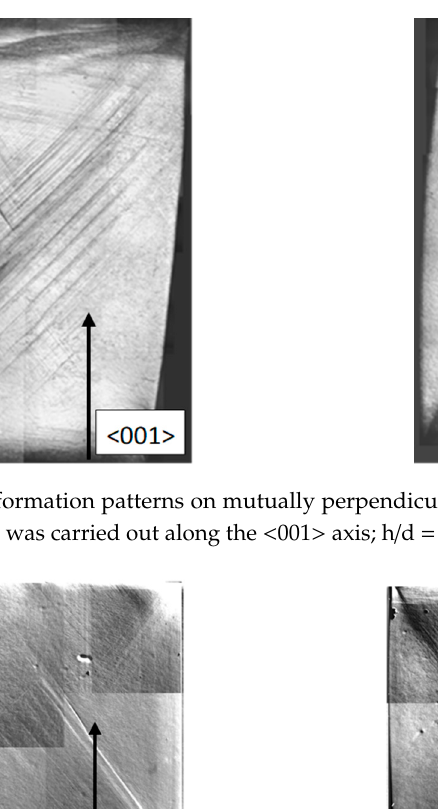
Figure 6. Surface deformation patterns in a simulated <001> Ni single crystal with {110} lateral faces: